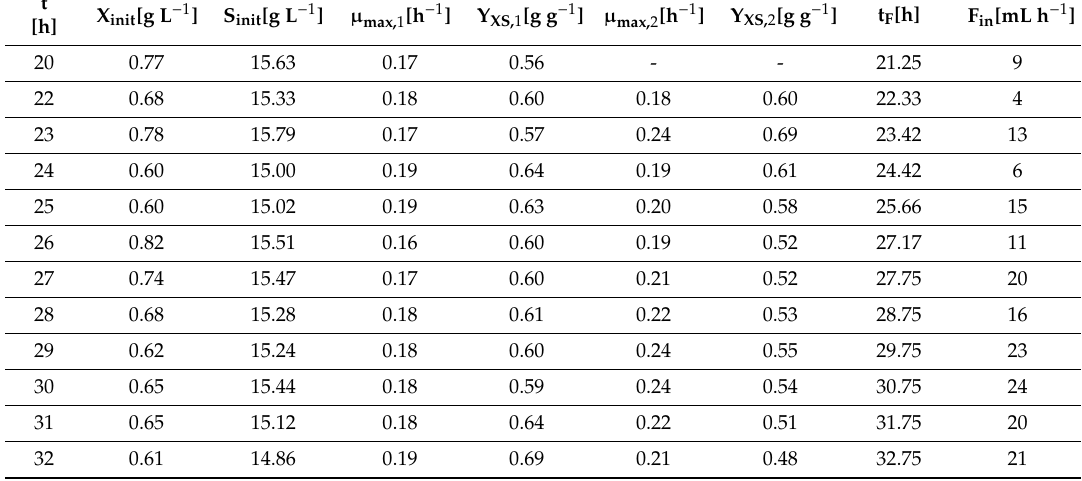
Table A18. Estimated initial concentrations for biomass X init and glucose S init and the estimated model parameters for the maximum specific growth rate biomass µ max and yield coe ffi cient biomass / substrate Y XS (for batch phase index 1 and for fed-batch phase index 2) at process timepoint t. Calculated optimized feed rate F in for timepoint t F